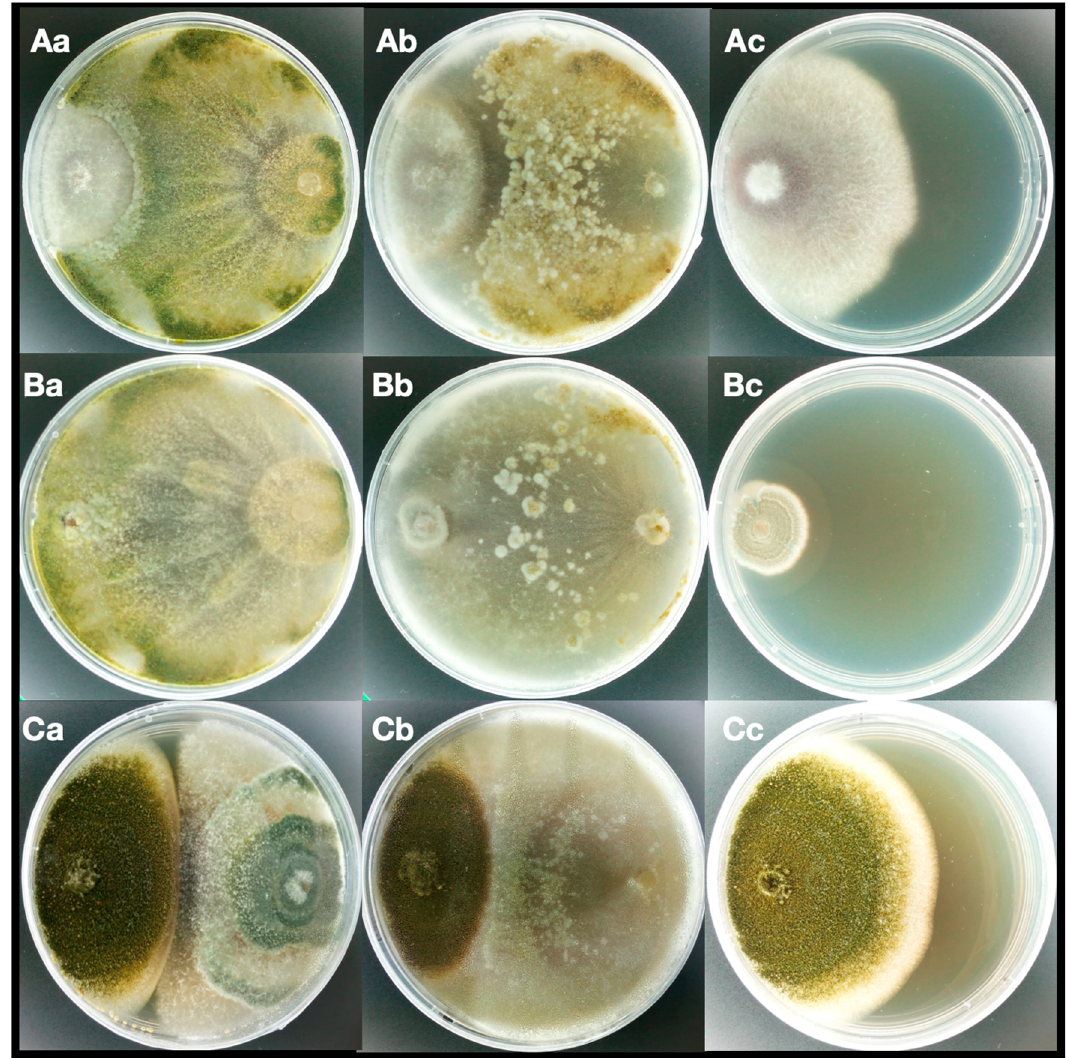
Figure 3. Dual culture assay after 7-days of incubation. Fusarium graminearum ( A ), Penicillium commune ( B ), and Aspergillus parasiticus ( C ) in coculture (left side of each plate) with Trichoderma atroviride TS ( a ), Trichoderma asperellum IMI393899, ( b ) and the control ( c ).